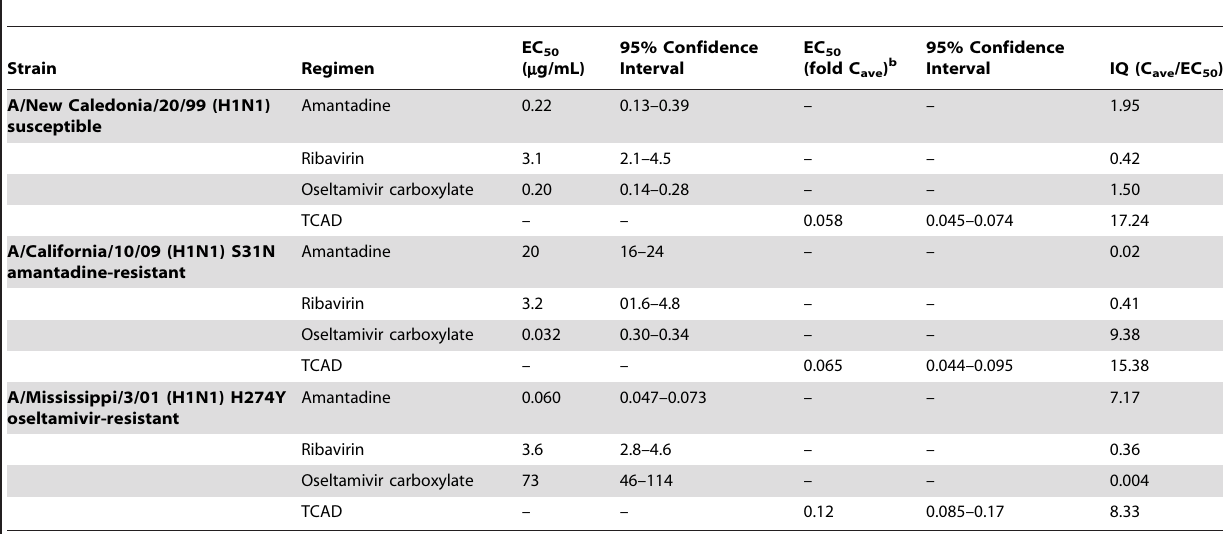
Table 4. The 50% effective concentrations (EC 50 ) and inhibitory quotients (IQ) for amantadine, ribavirin, oseltamivir carboxylate, and TCAD a against representative susceptible and resistant